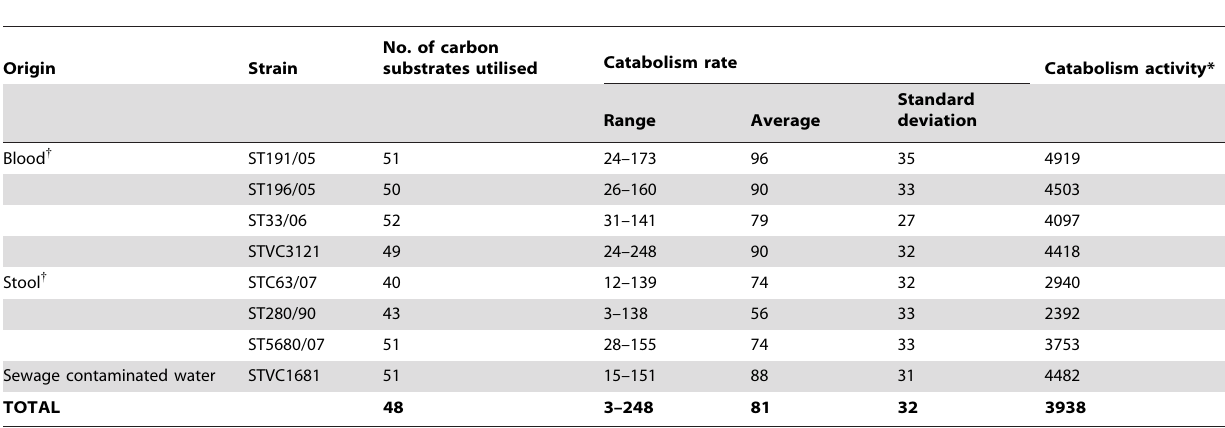
Table 3. Carbon catabolic activity among Salmonella enterica serovar Typhi strains isolated from human blood, stool and sewage- contaminated